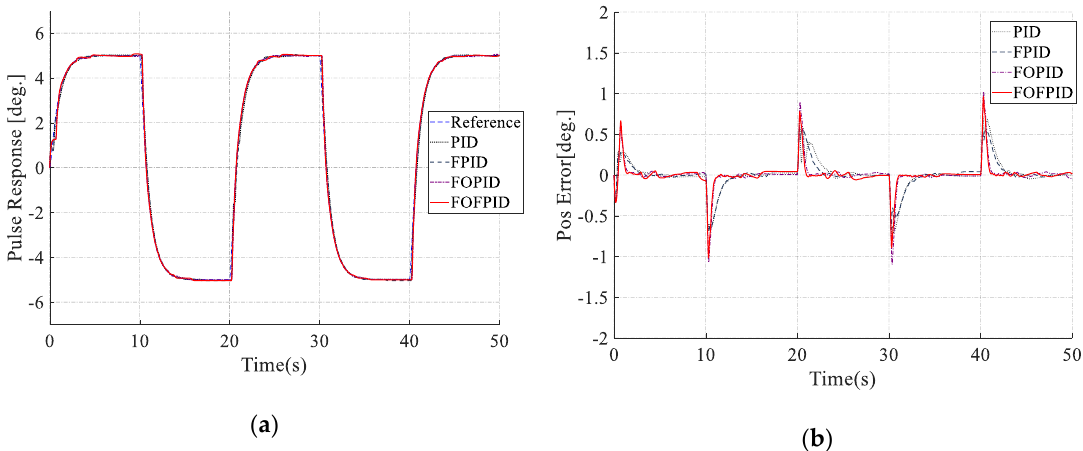
Figure 13. Comparison for pulse trajectory (cutoff frequency 9 Hz and the payload is 50 N). ( a ) Output performance; ( b ) error effort.